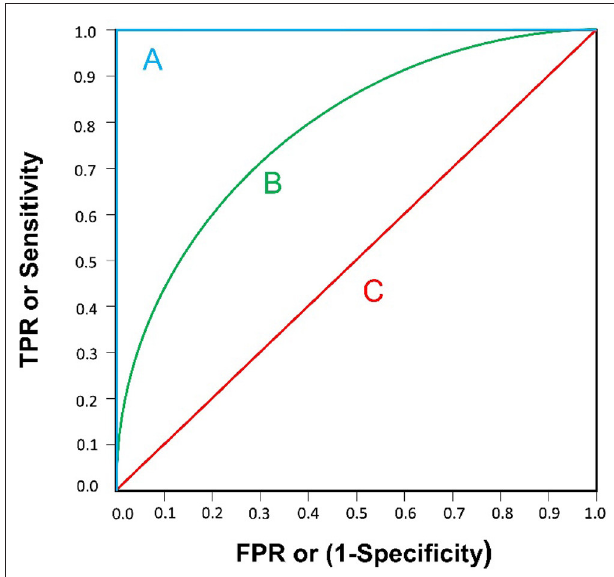
FIGURE 1 | Three examples of ROC curve are illustrated. (A) AUC = 1: A “perfect” classifier; (B) 0.5 < AUC < 1: A real-world classifier, better than random guess; (C) AUC = 0.5: Like random guess (e.g., coin tossing), models have no predictive